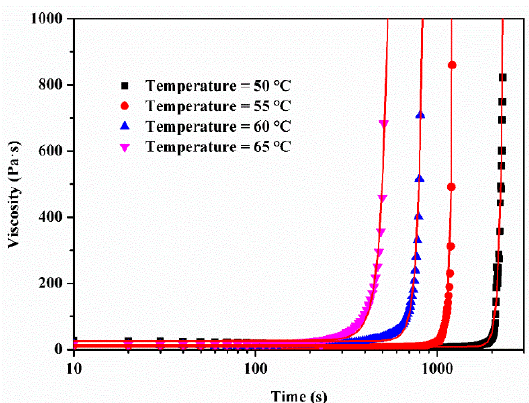
Figure 6. Semilog plots of viscosity as a function of gelation time for 42.0 vol.% KNN suspensions with 15.0 wt.% hydantoin epoxy resin at different temperatures.